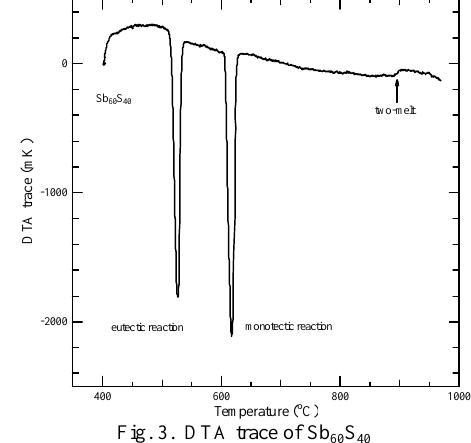
Fig. 3. DTA trace of Sb 60 S